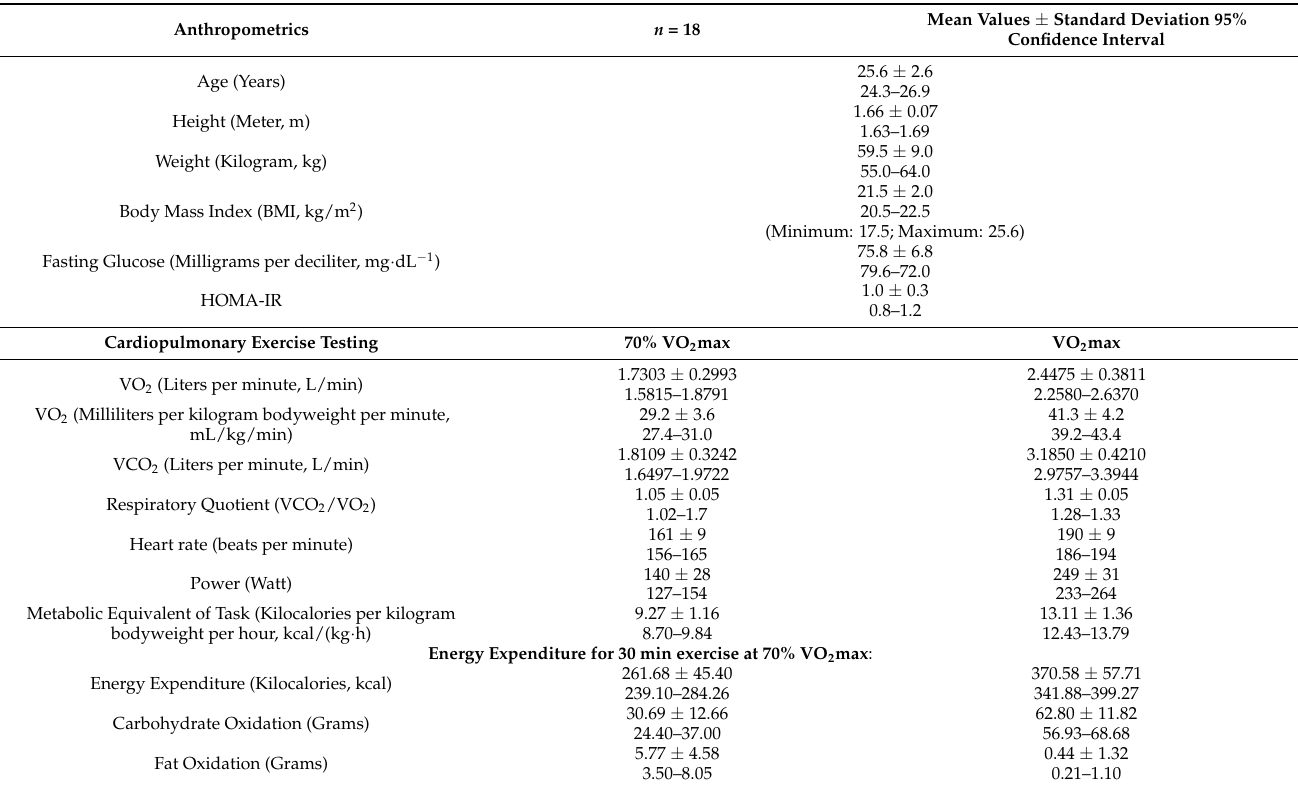
Table 1. Baseline demographic and clinical characteristics, including results of the cardiopulmonary exercise testing including measures of energy